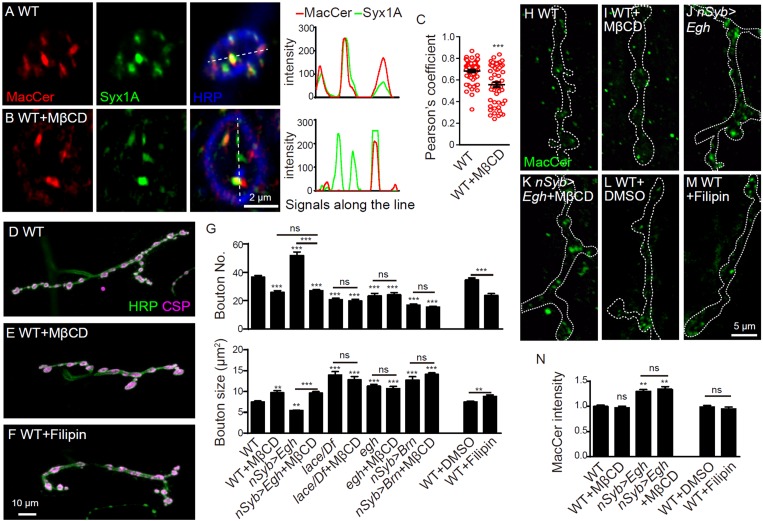
Sterol-depletion inhibits NMJ growth in a common genetic pathway with MacCer.(A and B) Confocal images of single slice of NMJ4 boutons triple-labeled with anti-MacCer (red), anti-Syx1A (green) and anti-HRP (blue) in wild type with or without 20 mM MβCD treatment. Plot profiles of the relative intensity along the dashed lines are shown. (C) Pearson’s coefficients of colocalization between MacCer and Syx1A. n = 63 and 52 boutons from eight wild-type larvae each with or without MβCD treatment. (D–F) Images of NMJ4 co-labeled for anti-HRP (green) and anti-CSP (magenta) in untreated wild type (D), wild type treated with 20 mM MβCD (E), wild type treated with 50 μg/ml filipin III (F), Scale bar: 10 μm. (G) Quantification of bouton number and bouton size of NMJs. ns, no significance, ***p<0.001 by one-way ANOVA with Tukey post hoc tests, error bars: s.e.m. (H–M) Images of NMJs from larvae stained with anti-MacCer of wild type (H), wild type treated with 20 mM MβCD (I), UAS-Egh/+; nSyb-Gal4/+ (J), and UAS-Egh/+; nSyb-Gal4/+ treated with 20 mM MβCD (K), wild-type larvae treated with vehicle DMSO (L) or 50 μg/ml filipin III (M). Scale bar: 5 μm. (N) Quantification of MacCer intensities normalized to HRP intensities in different genotypes. ns, no significance; **p<0.01 by one-way ANOVA with Tukey post hoc tests; n ≥ 12 larvae; error bars: s.e.m.10.7554/eLife.38183.012Figure 4—source data 1.Numerical data for the statistical graphs.